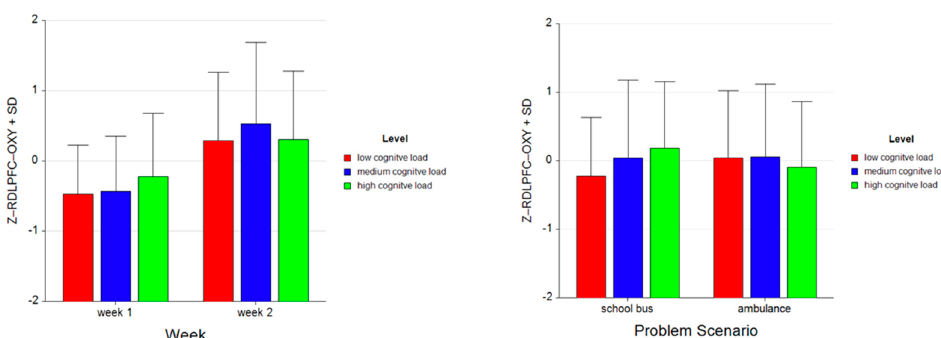
Figure 14. Bar charts represent average standardized z-scores for oxygenation for right dorsolateral prefrontal cortex (Z-RDLPFC-OXY) and standard deviation (SD) for low cognitive load, medium cognitive load, and high cognitive load tasks for experiment Week 1 and Week 2 (left) and School Bus and Ambulance problem scenarios (right).